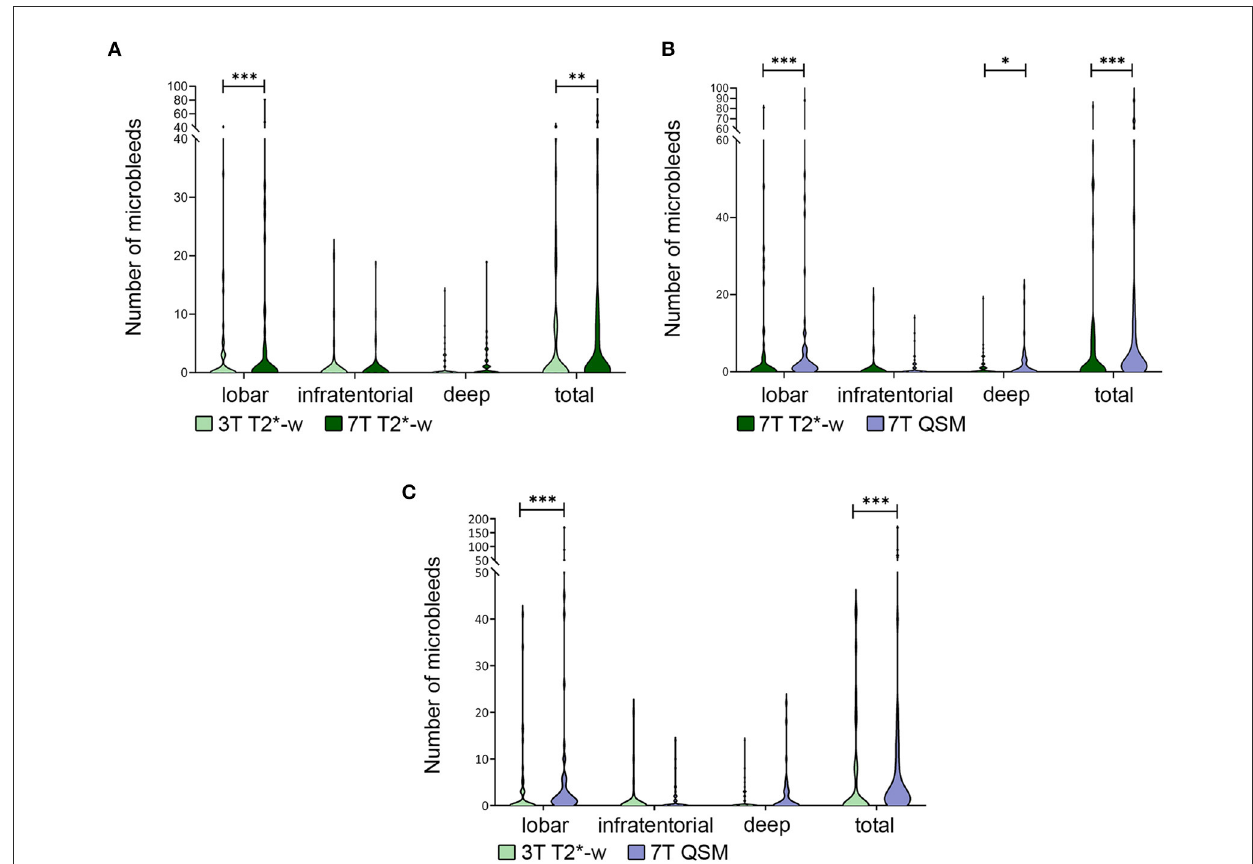
FIGURE3 Differences in number of microbleeds. Legend: Violin plot showing the difference in total number of microbleeds (MBs) and in different brain localizations in 3T vs. 7T T2*-w imaging (A) , 7T T2*-w imaging vs. 7T QSM (B) , 3T T2*-w imaging vs. 7TQSM (C) . The difference in total number of detected MBs is always significant and driven by the difference in number of those in lobar localization. * p < 0.05; ** p < 0.01; *** p <